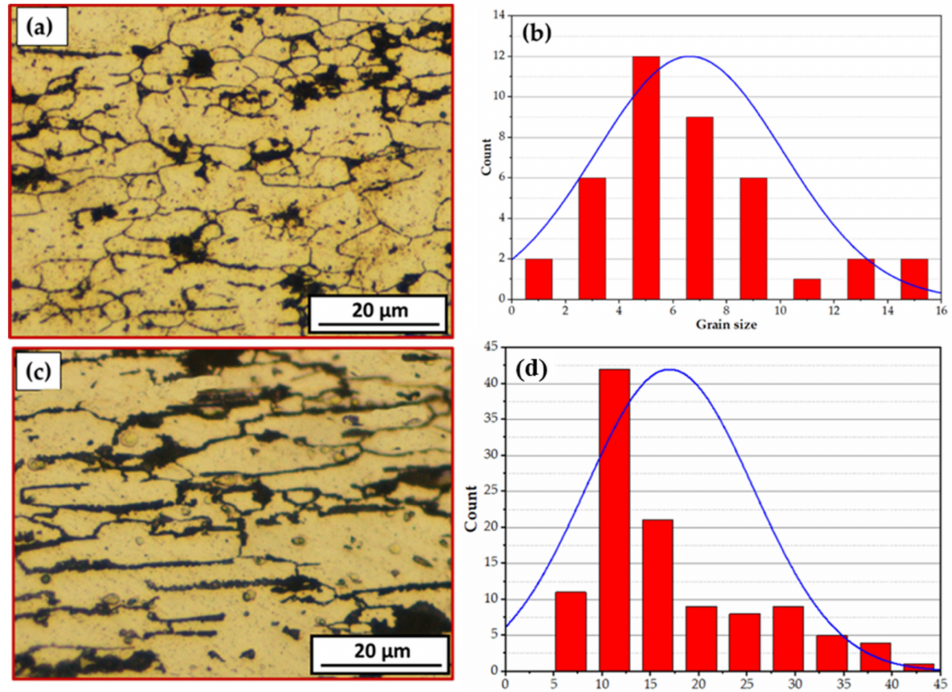
Figure 9. OM images, ( a , c ) and grain size histograms, ( b , d ) of AA6082-T6 sheet BMs of 1 mm and 2 mm thickness,